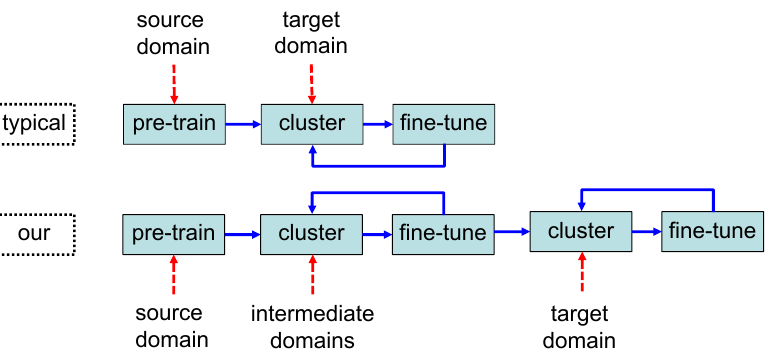
Figure 2. The comparison of UDA ReID pipeline between our proposed method and typical method. We utilize the intermediate domains as a bridge to narrow the domain gap between source and target